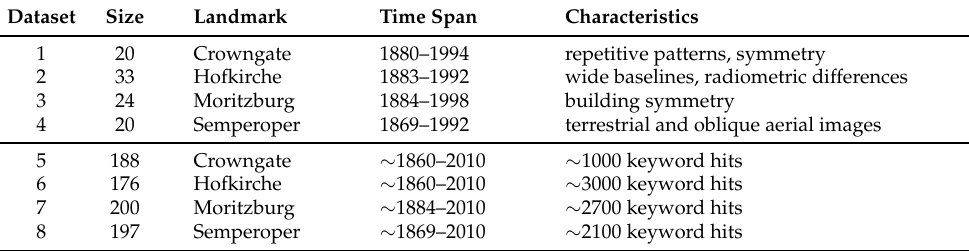
Table 1. Overview of eight datasets including total number of images, time span, and